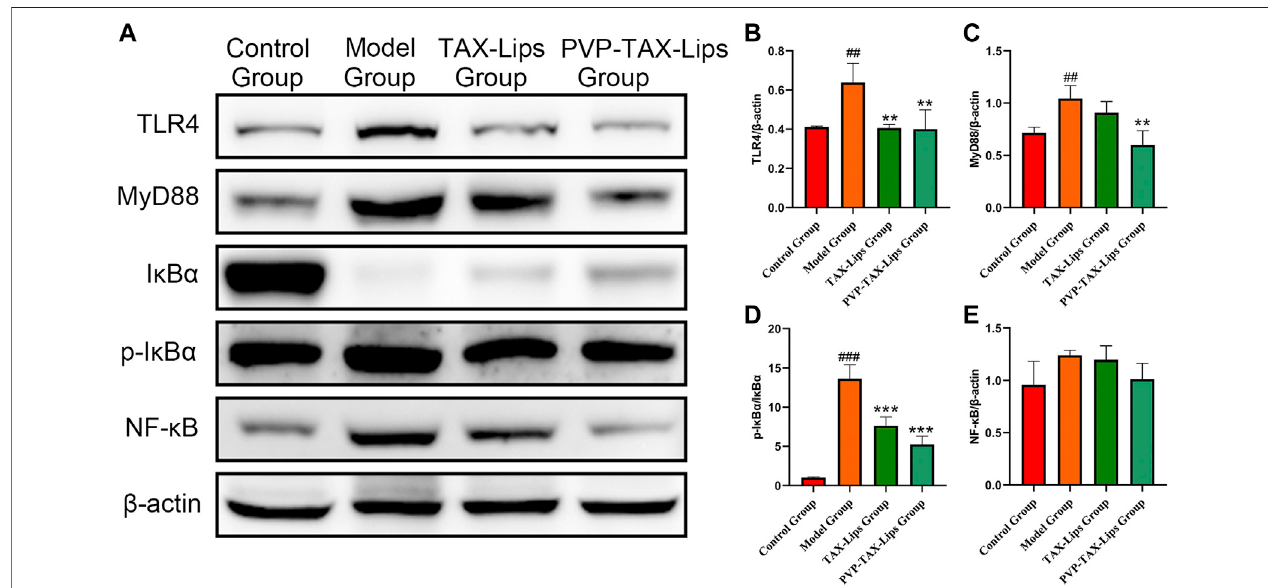
FIGURE 6 | Expression of TLR4/NF- κ B signaling pathway induced by LPS/D-GalN. (A) Protein levels of TLR4, MyD88, I κ B α , p-I κ B α , NF- κ B, and β -actin analyzed by Western blotting. (B – E) Relative band intensity analyzed by ImageJ Analysis System, and β -actin was used as a control for equal loading. As compared with the control group, ## p < 0.01, ### p < 0.001; As compared with the model group, ** p < 0.01, *** p < 0.001. The data are presented as the mean ± SD ( n = 3).